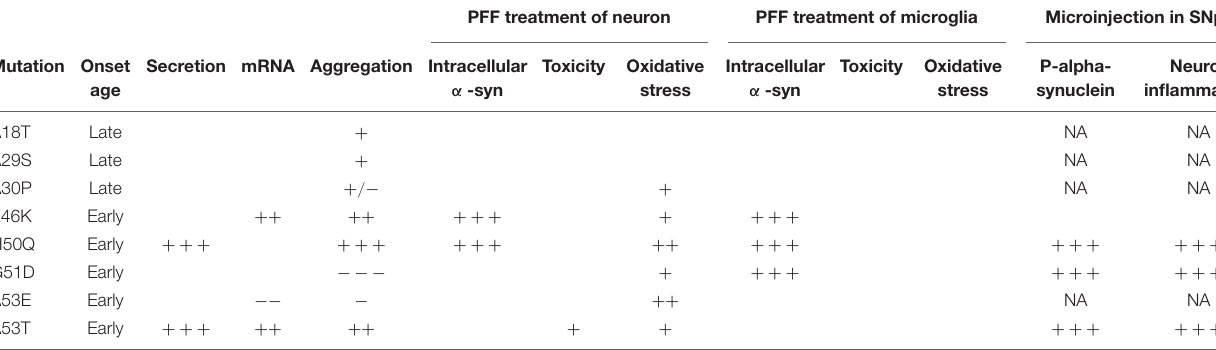
TABLE 2 | Effects of pathogenic